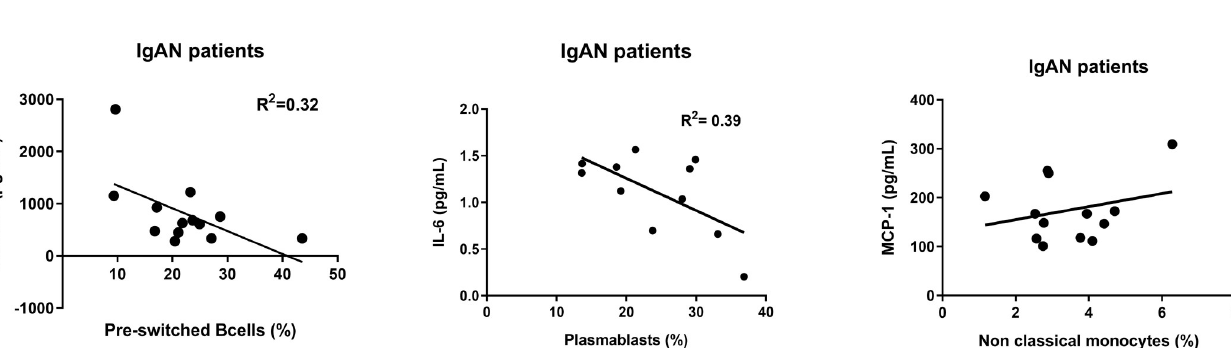
Fig 6. The relationship between cytokines and albuminuria. The relationship between MCP-1 / sCD40L levels and albuminuria in IgAN patients using linear regression test.